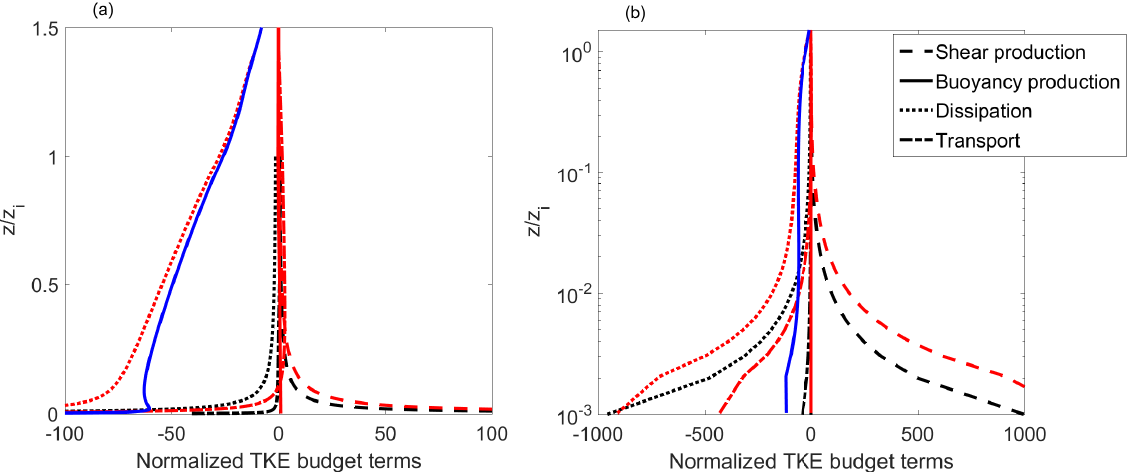
Figure A2. Normalized terms in the turbulence kinetic energy equation from Lenschow (1974) (in black) and our model (in red) for a very near neutral case with z i /L equal to − 1, z i ≈ 1000m and a surface roughness length z 0 = 0 . 02m. Buoyancy production, shear production, dissipation and transport are shown with full, dashed, dotted and dash-dotted lines, respectively, for normalized height z/z i in panel (a) and with a logarithmic y axis in panel (b) . The TKE tendency term in our model is shown in blue.